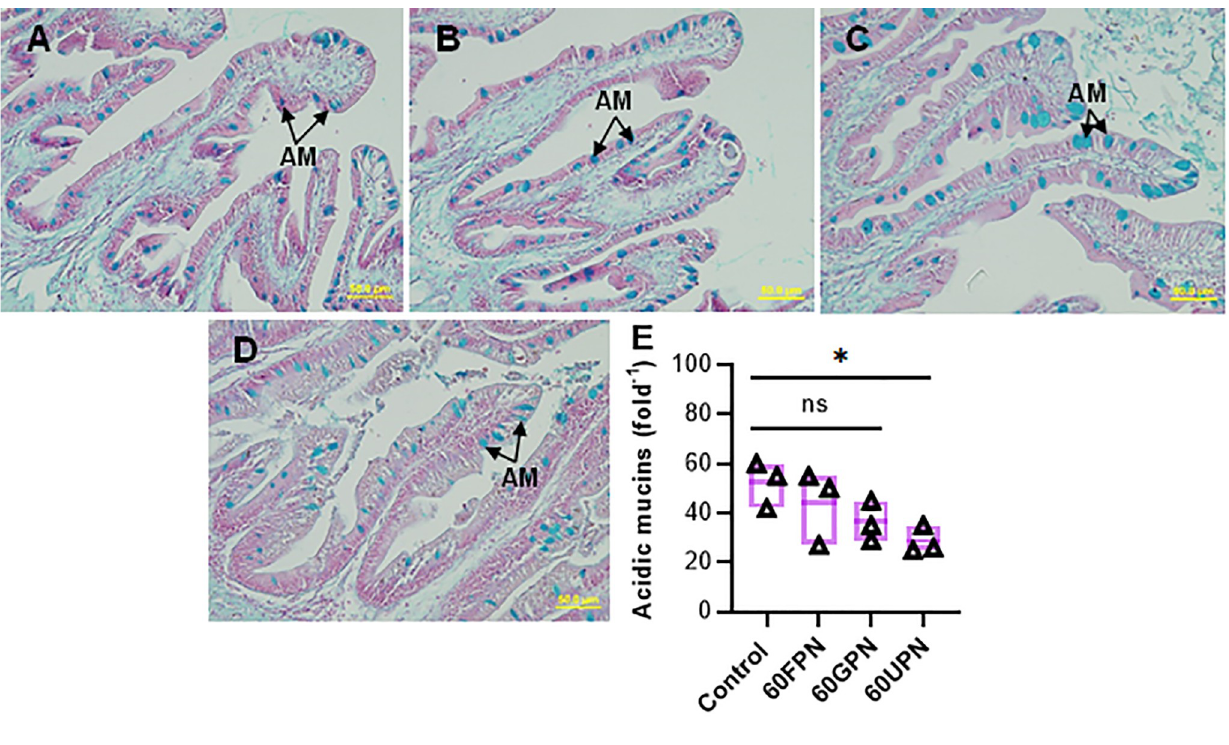
Fig 4. Histological structure of the intestinal section of juvenile barramundi fed control, 60FPN, 60GPN and 60UPN diets (A-D, respectively) (Alcian blue staining, 40 x magnification, scale bar = 50 μ m). Black arrow indicates acidic mucin cells. Variation in the acidic mucins in the intestine of fish fed control, 60FPM, 60GPM and 60UPM over 8 weeks (E). Significant at � P < 0.01 (one-way ANOVA with Dunnetts multiple comparisons test). ns: not significant.